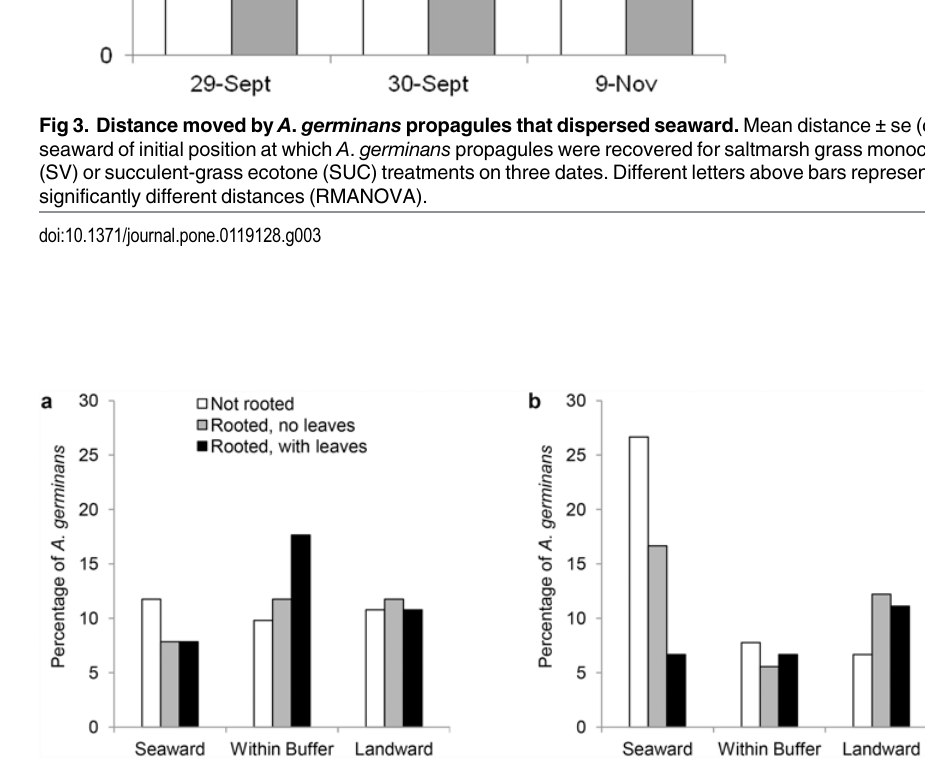
Fig 4. Establishment of A . germinans on 9 November 2012. Initial establishment success was evaluated by categorizing the rooting status and leaf development of A . germinans six weeks after propagule emplacement into two saltmarsh treatment a) saltmarsh grass monoculture (SV) and b) succulent-grass ecotone (SUC). The percentages of A . germinans propagules in the three categories of seedlings establishment at three positions relative to the starting position (0 m) within the saltmarsh are presented for each of the saltmarsh treatments.